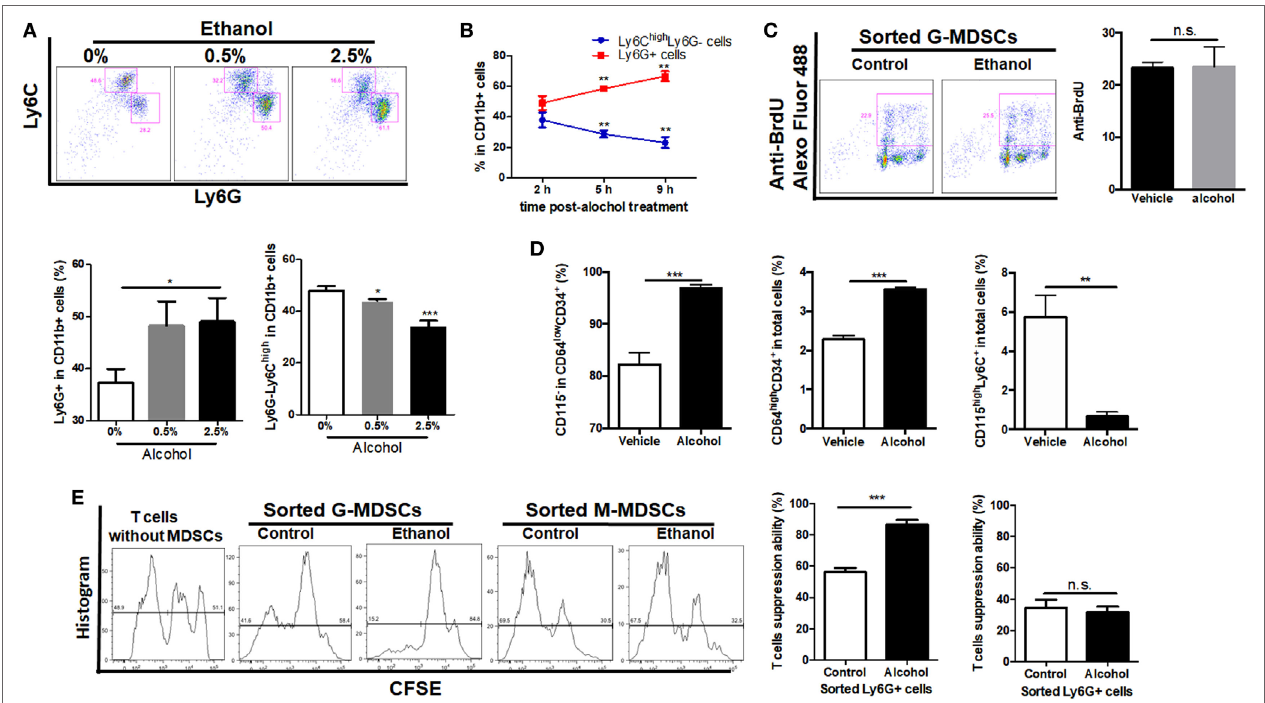
FigUre 4 | Effect of ethanol on the differentiation, expansion, and function of myeloid-derived suppressor cells (MDSCs) populations in vitro . Bone marrow-derived cells were isolated from naïve mice and treated directly with 0.5 or 2.5% ethanol in RPMI-1640 medium supplemented with 10% FBS. After culturing for 2, 5, and 9 h, cells were collected for the examination of MDSCs population via flow cytometer. (a) Representative images and quantification of flow cytometric analyses granulocytic-MDSCs (G-MDSCs) populations treated with ethanol at different concentrations. (B) Time course of population of G-MDSCs and monocytic-MDSCs (M-MDSCs) cultured with ethanol at the concentration of 0.5% (vol/vol). (c) Representative images and quantification of flow cytometric analyses anti-BrdU Alexo Flour 488 staining. Bone marrow-derived cells were labeled with BrdU at a final concentration of 10 µM. Then, cells were analyzed by flow cytometer. The proliferation of G-MDSCs was not increased by ethanol treatment. (D) Populations of common myeloid precursor, granulocyte-monocyte progenitors (GMPs), and monocyte-committed progenitors produced by GMPs (MP) in bone marrow-derived cells treated with ethanol or vehicle determined by flow cytometer. (e) Representative images of flow cytometric analyses of carboxyfluorescein succinimidyl ester (CFSE) intensity in CFSE-CD8 + T cells co-cultured with G-MDSCs populations or M-MDSCs treated with ethanol or vehicle. Data were analyzed as mean value ± SD and Student’s T -test was used to assess the result significance. * p < 0.05, ** p < 0.01, *** p < 0.001, compared with the control group; n.s., not